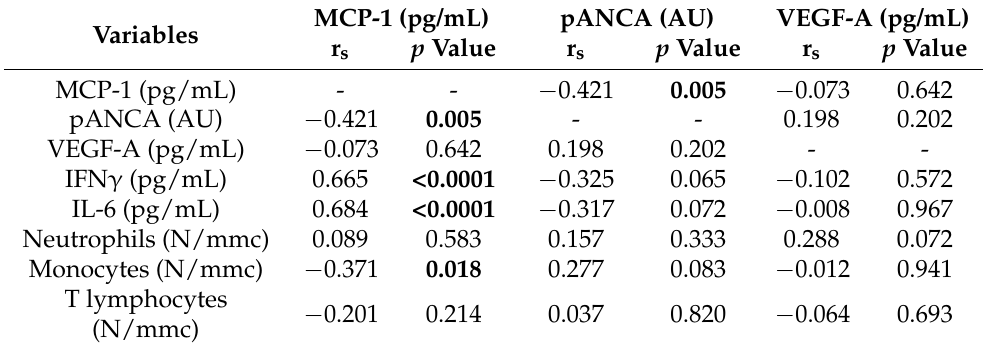
Table 1. Spearman correlation analysis in MIS-C